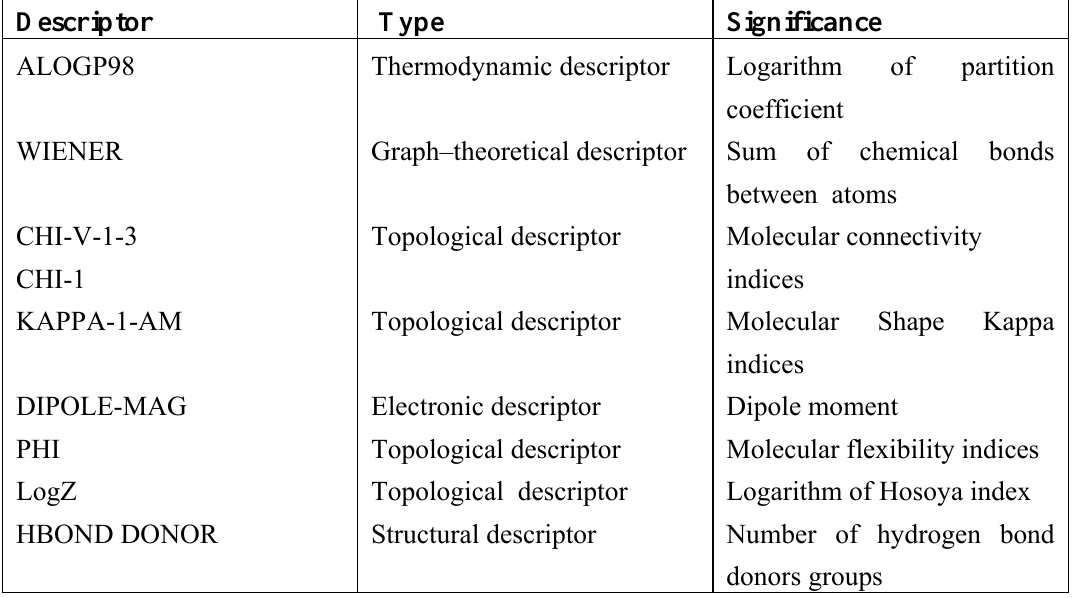
Table 1. Significance of descriptors used in this QSAR